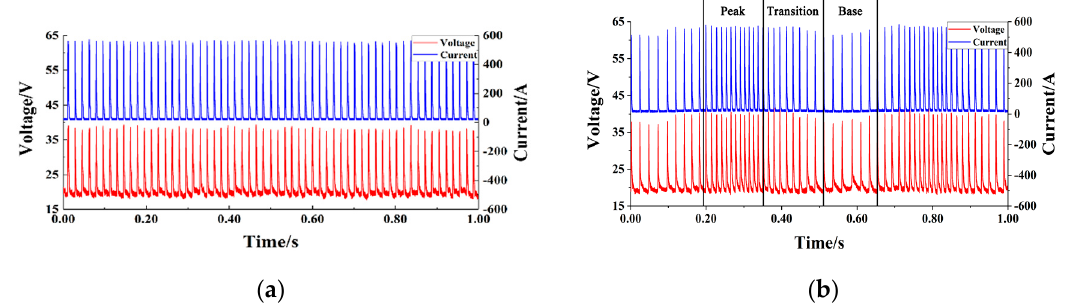
Figure 6. Welding electrical signal waveform of ( a ) P-GMAW(No.12); ( b ) DP-GMAW(No.3).